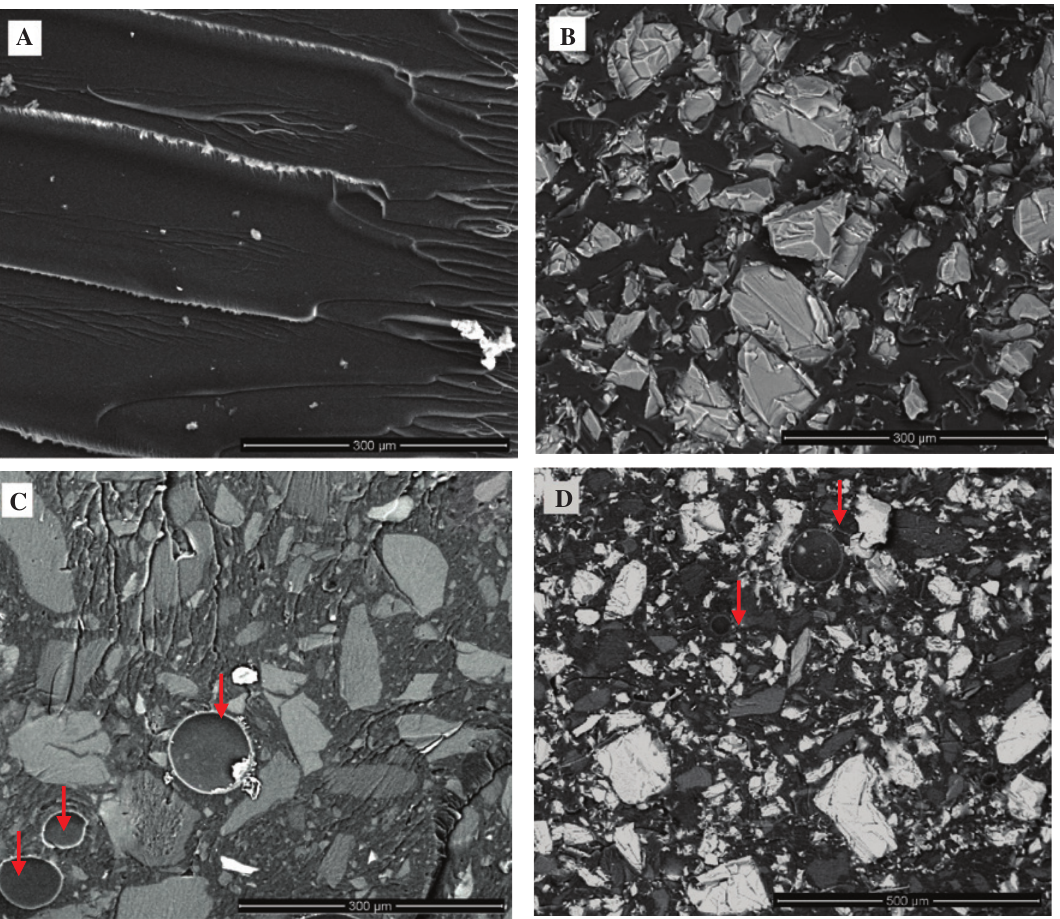
Figure 1: Representative SEM micrographs of the: (A) neat epoxy, (B) 20APP, (C) 20AG and (D) 5AG15APP samples showing effective disper- sion of AG and APP